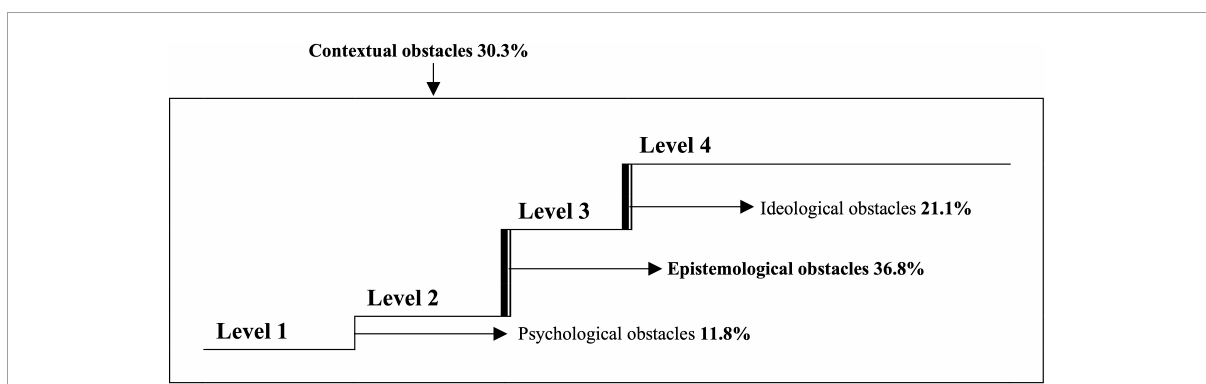
FIGURE5 Network conceptions of university and values to be promoted.